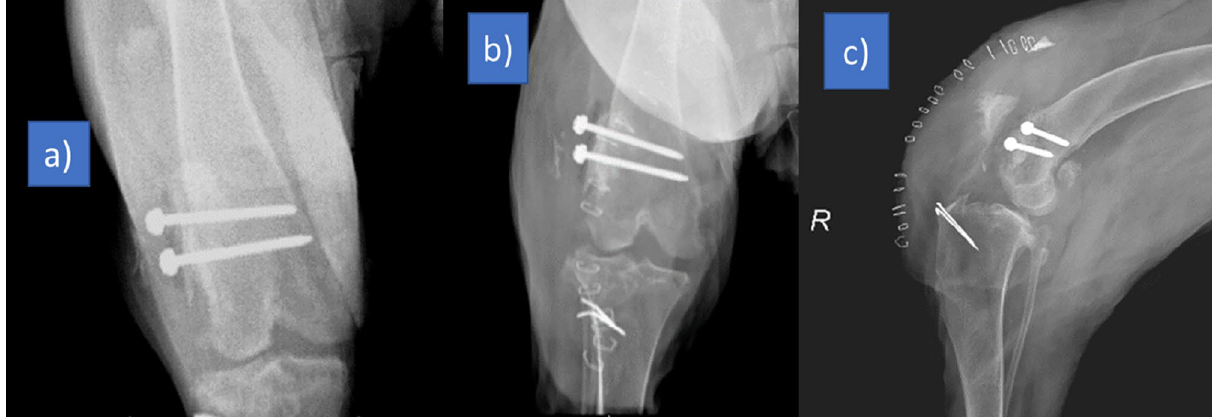
Figure 9. Postoperative anterior–posterior radiograph of the femur on 50 days ( a ), posterior–anterior ( b ) and lateral ( c ) radiograph on the 80 days. Both on 50 and 80 days there were no implant movement and implant- bone reaction. Patella did not luxate. However, there was a fistule problem before the operation. It progressed and made inflammation. The swelling can be seen on lateral radiograph ( c